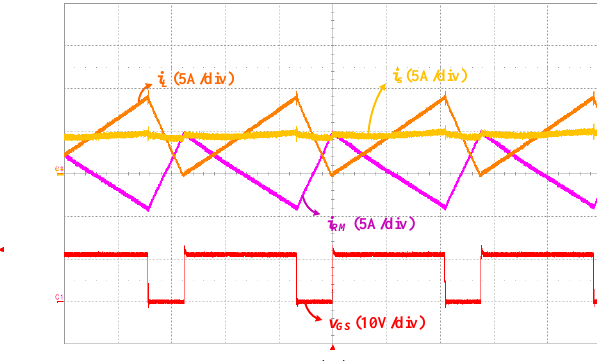
Figure 13. Current waveforms of the proposed converter under ( a ) half, and ( b ) full load conditions (50